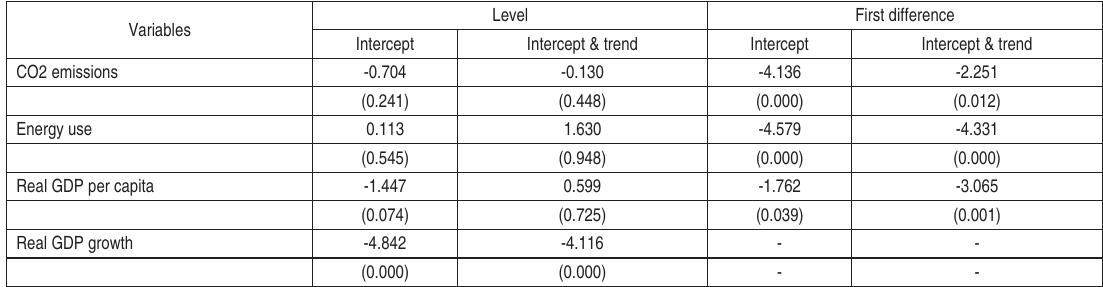
Table 1. Pesaran (2007) panel unit root test in the presence of cross-section